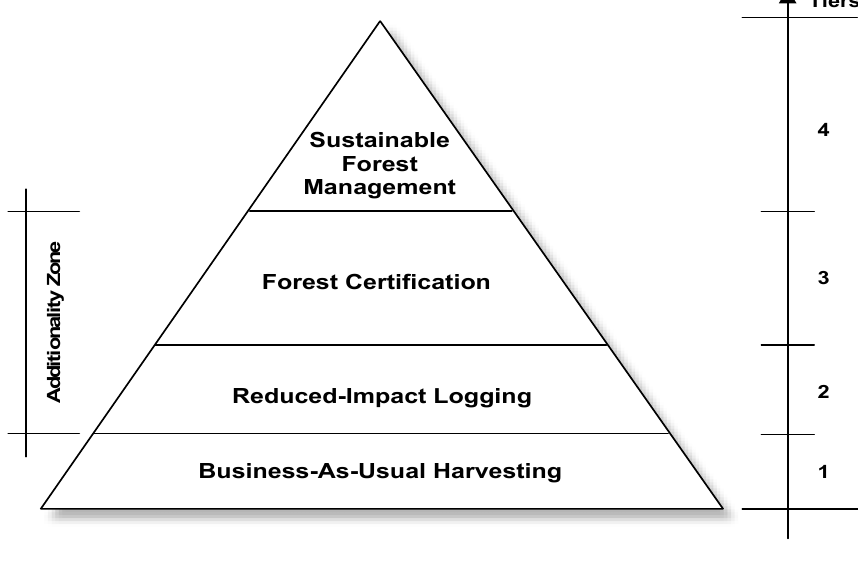
Figure 1. Hierarchy of production forest